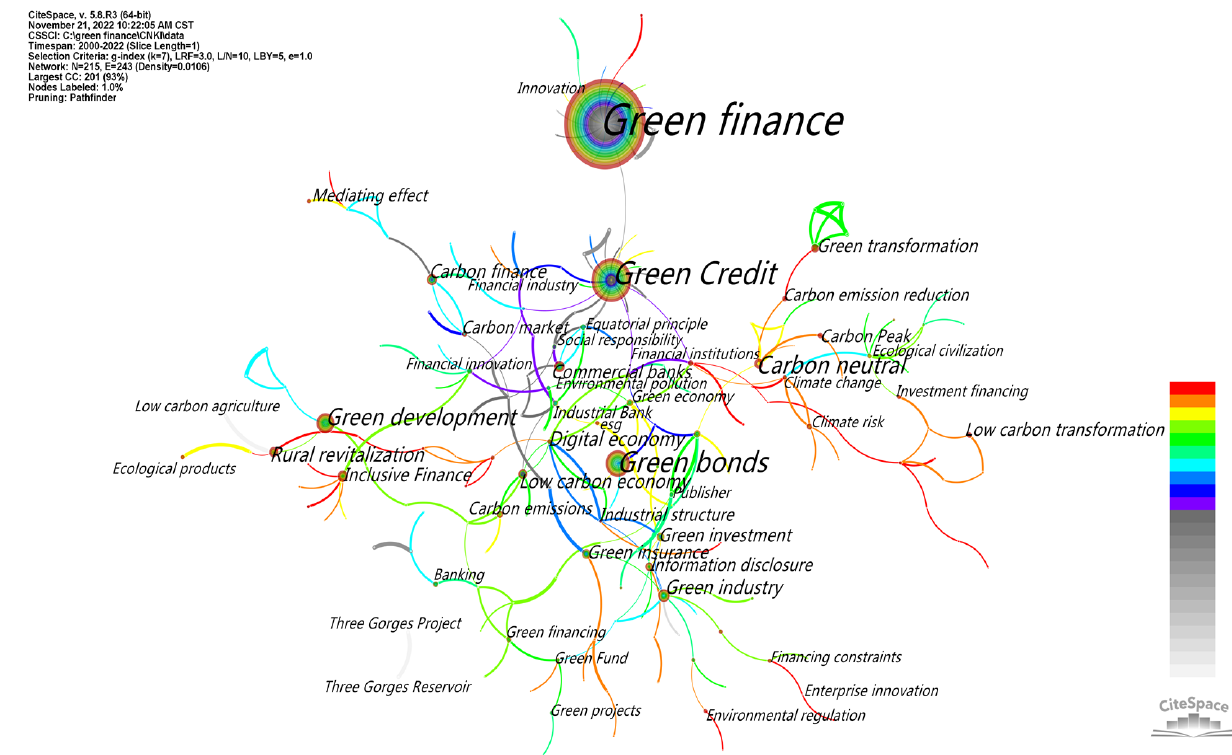
Figure 8. CNKI keyword co-occurrence.